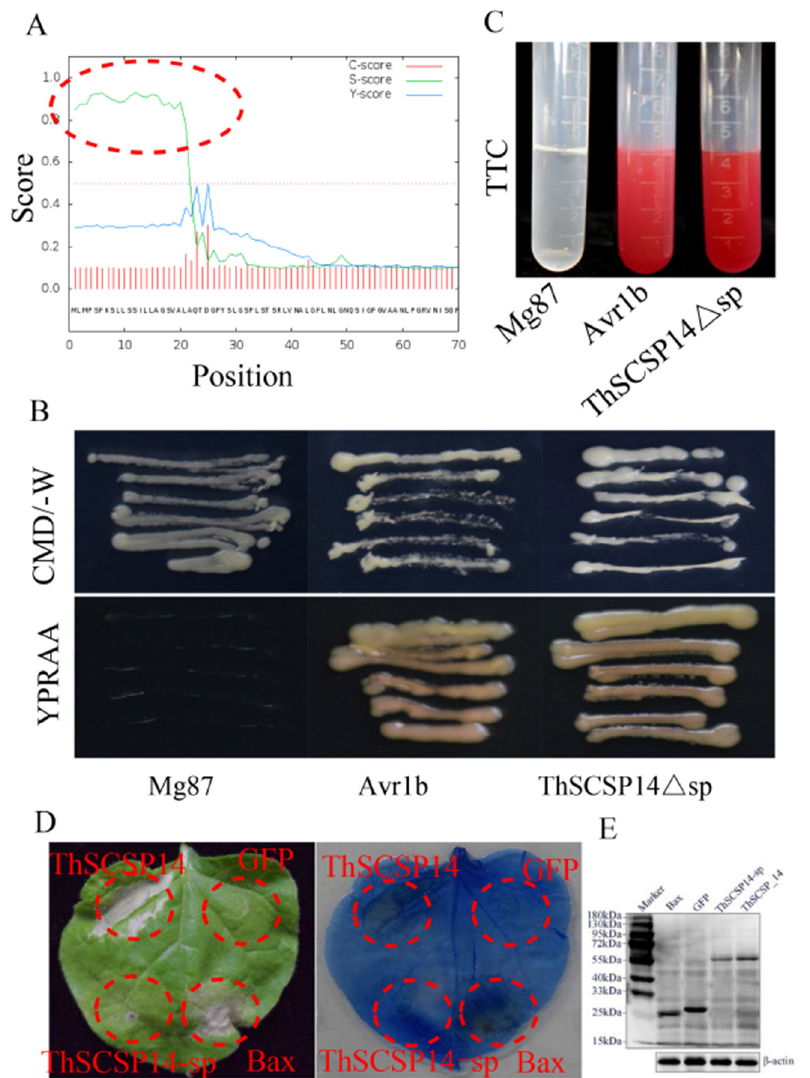
Figure 3. Functional analysis of ThSCSP_14 (cid:48) s signal peptide (SP) sequence (ThSCSP_14 ∆ sp). ( A ) The SP sequence was predicted in ThSCSP_14. ( B ) The yeast invertase secretion assay was used to identify the secretory function of ThSCSP_14 ∆ sp. To cultivate the transformed YTK12 yeast strains, the CMD-W and YPRAA media with raffinose as the sole carbon source were each used. The positive control is SP sequence of Phytophthora sojae Avr1b; the and negative control is the SP sequence of Magnaporthe oryzae Mg87. ( C ) Enzymatic activity of invertase was identified by performing the 2, 3, 5-triphenyltetrazolium chloride experiment. The positive control is the SP sequence of P. sojae Avr1b; the negative control is the SP sequence of M. oryzae Mg87. ( D ) ThSCSP_14 ∆ sp is required to induce cell death. ( E ) The protein’s expression in Nicotiana benthamiana observed by Western blot experiments. ThSCSP_14-sp denoted the sequence of ThSCSP_14 without